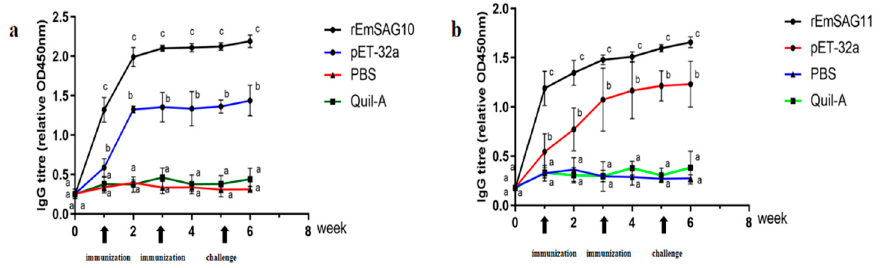
Figure 6. Changes of specific antibody levels in the serum of r EmSAG10 ( a ) and r EmSAG11 ( b ). Immunization: first and second immunizations with the vaccine, Challenge: challenge with E. mange . ( a ), Detecting the IgG antibody in the vaccination groups and the control group by r EmSAG10 proteins-based ELISA. ( b ), Detecting the IgG antibody in the vaccination groups and control group by r EmSAG11 proteins-based ELISA. All groups were challenged with 1 × 10 5 sporulated oocysts of E. magna . Different superscripts in small letters (a, b, c) indicate significant differences in the serum IgG values within each group over time. All values were estimated by ANOVA (Duncan’s post hoc) at p ≤ 0.05.